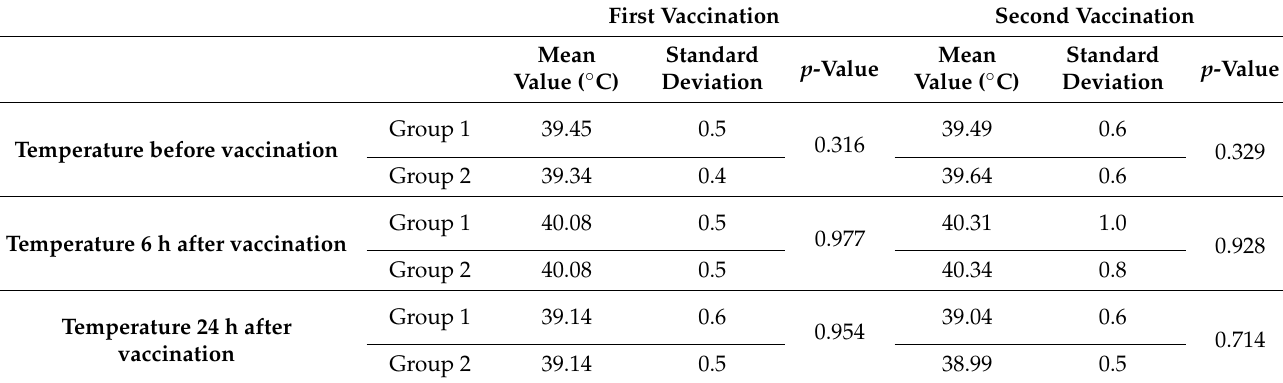
Table 3. Temperature measurement at both